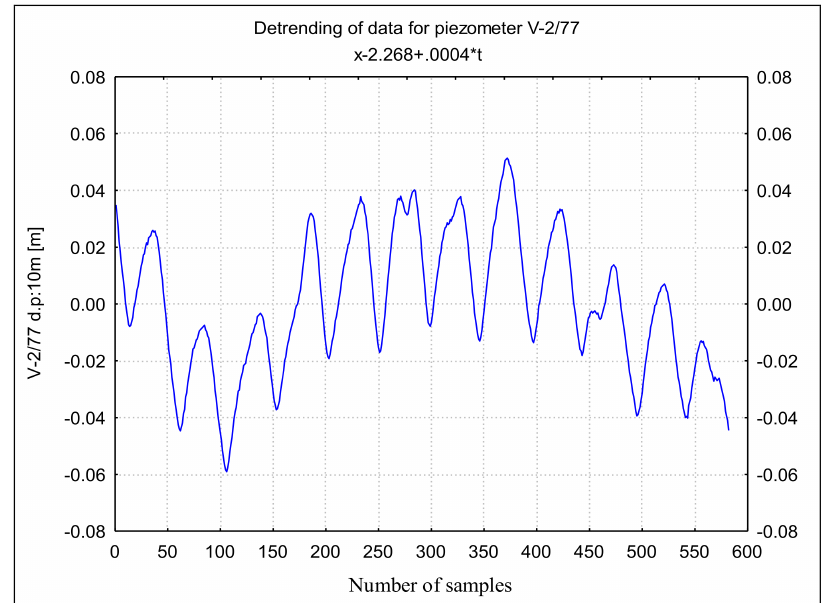
Figure 5. Detrended groundwater level oscillation of V-2/77 in